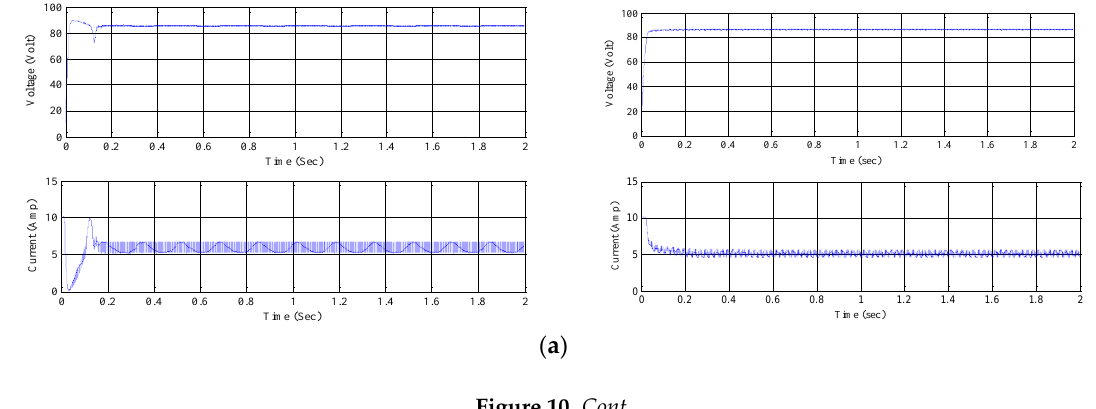
Figure 9. Result obtained of best fitness and number of variable by genetic algorithm (GA)